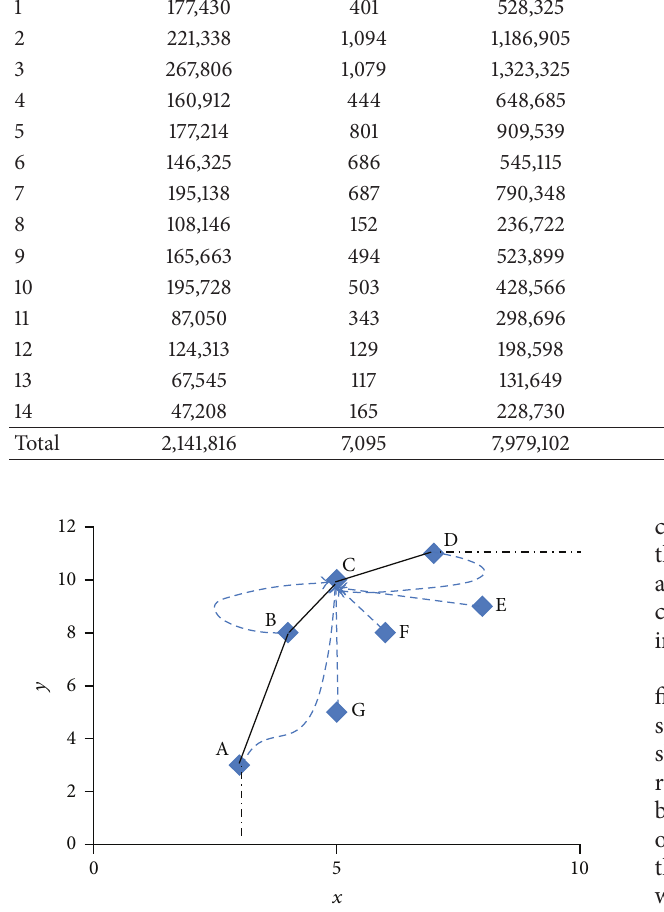
Figure 5: The CRA-CSBM projections onto the frontier